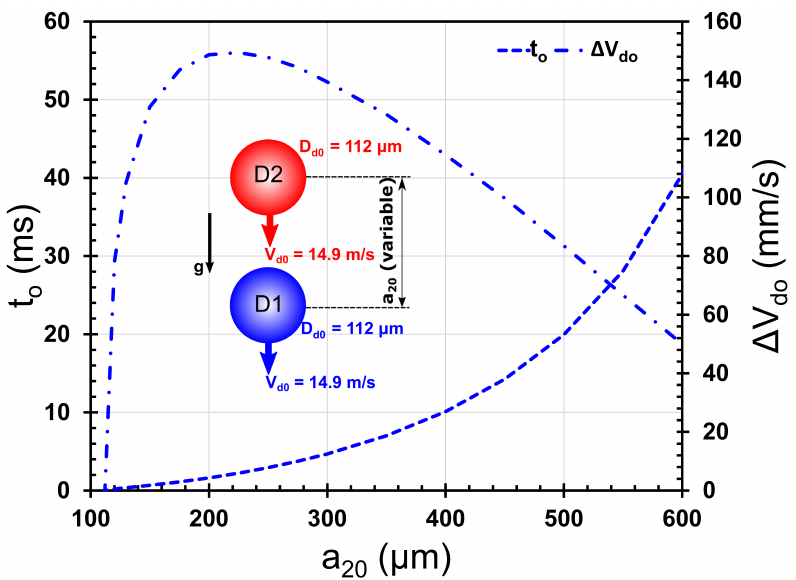
Figure 13. Effect of a 20 on t o and ∆ V d 0 : The effect of the initial center-to-center droplet separation on the time taken by the droplets to come in contact with each other for the first time and their approach velocity at this instant. Other parameters are the same as in Figure 4: D d 0 = 112 µ m; V d 0 = 14.9 m/s; C D is calculated using Equation